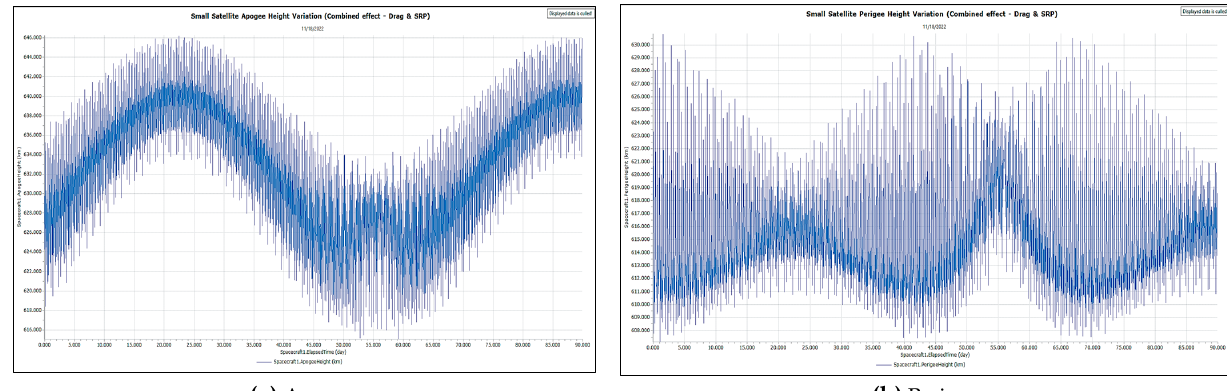
Figure 7. C hanging heights of a satellite from Earth’s surface for 90 days due to SRP-Drag. Now, instead of height, apogee and perigee heights along with solar flux were calcu- lated to observe the environmental variations and subjected to propagation for 90 days as shown in Figure 8 and Figure 9.